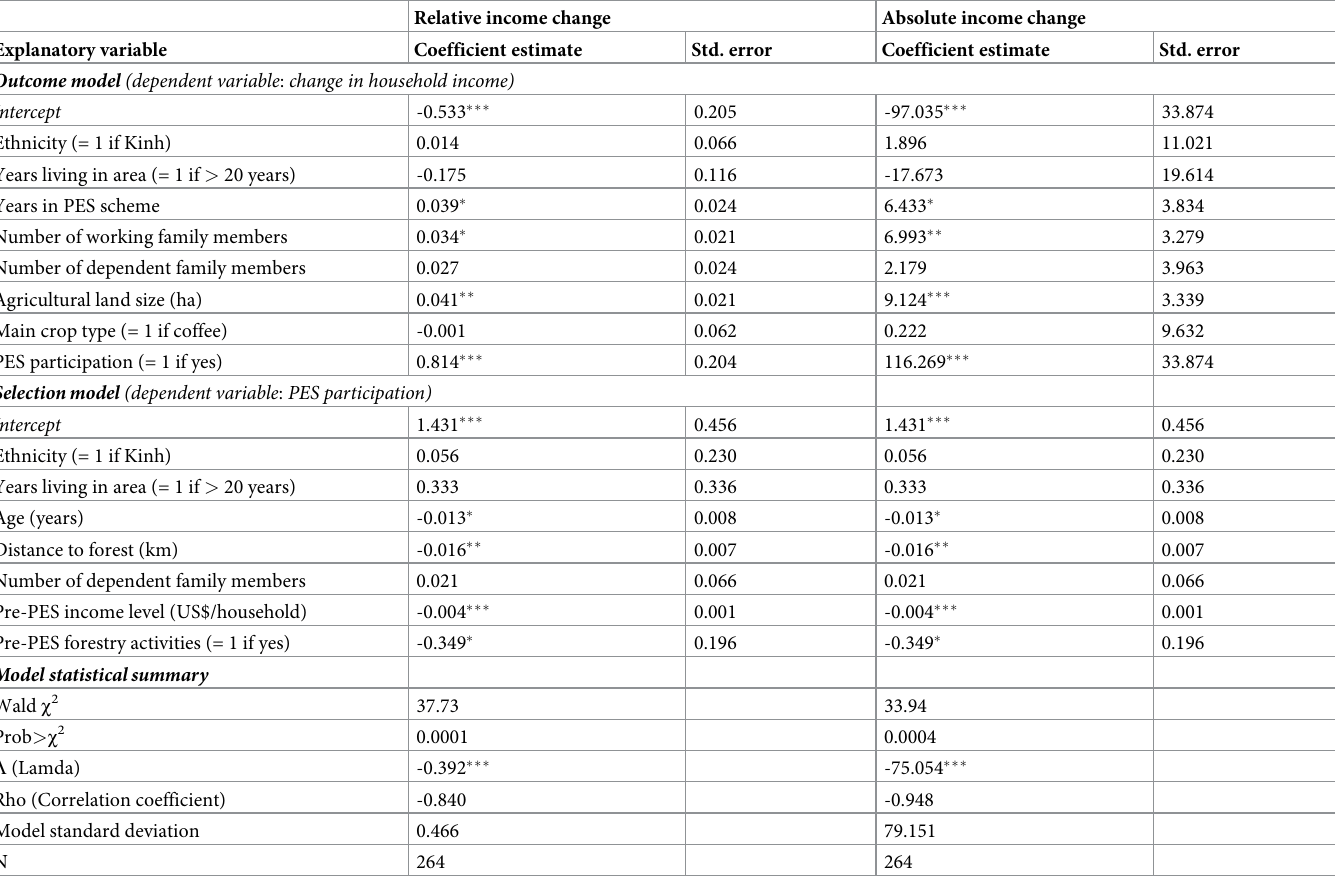
Table 1. Results of the treatment effects model. Relative income change Absolute income